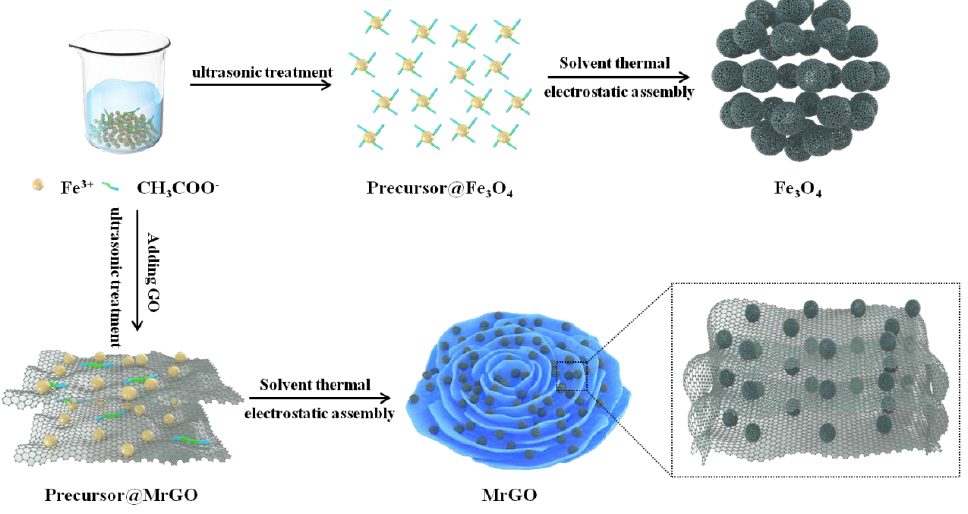
Figure 1. Schematic illustration of preparing the MrGO nanocomposite.